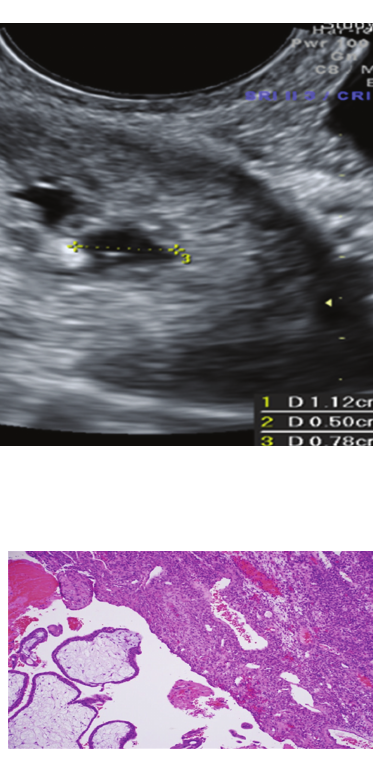
Figure 3: Histopathology revealed ovary with immature chorionic villi consistent with ectopic pregnancy. On the left lower field there are immature chorionic villi. On the right side is ovarian stroma with a primoridal follicle by the double